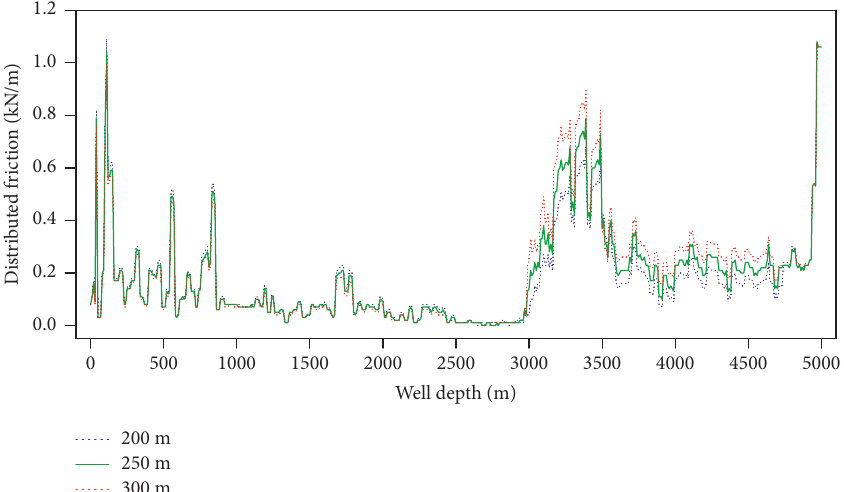
Figure 12: Influence of tool installation position on friction.